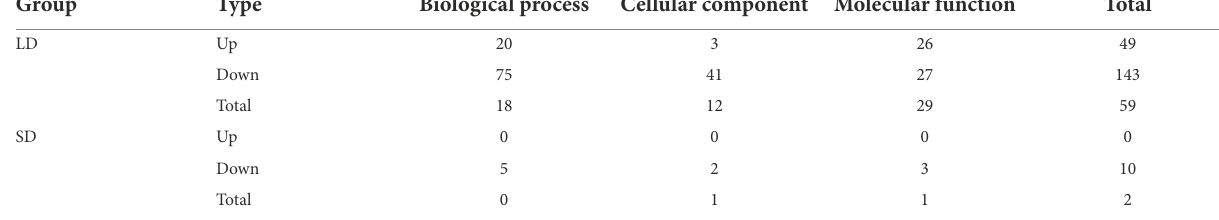
TABLE 2 GO items between transgenic GmFT3a soybean and control in LD and SD conditions.